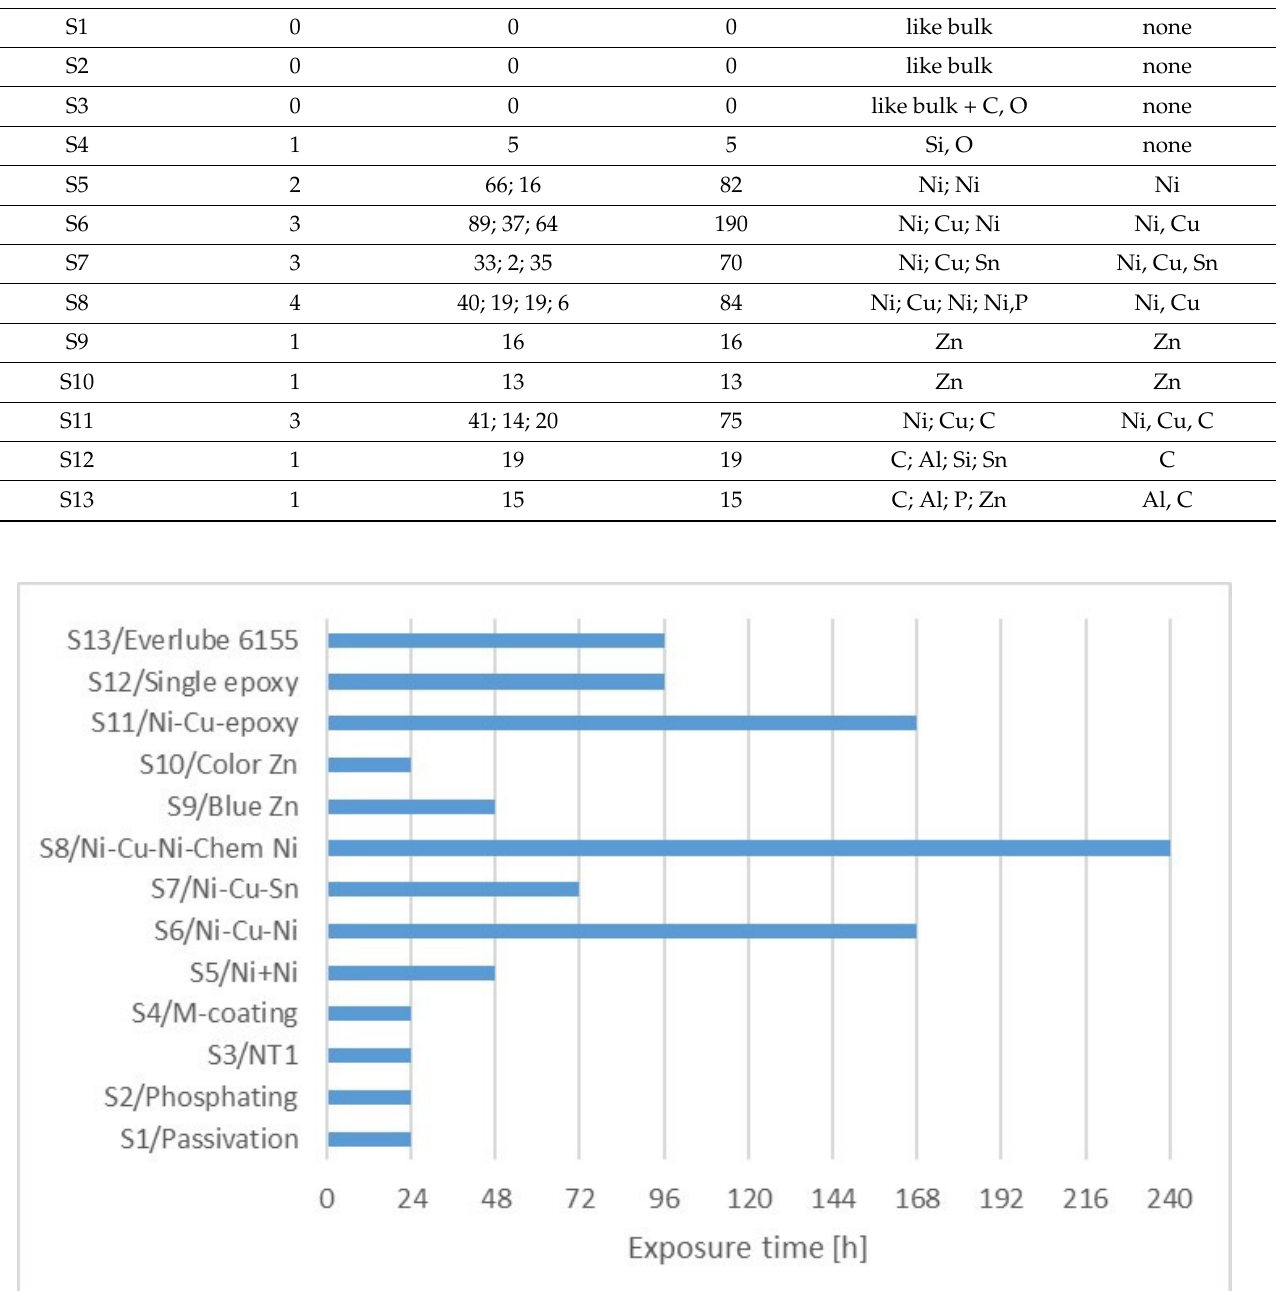
Table A2. Coating thickness and elemental distribution, analysed with SEM (see also Figure A2) and measured elemental coating residues analyzed by ICP-OES and C/S (see also Figures A5 and A6).